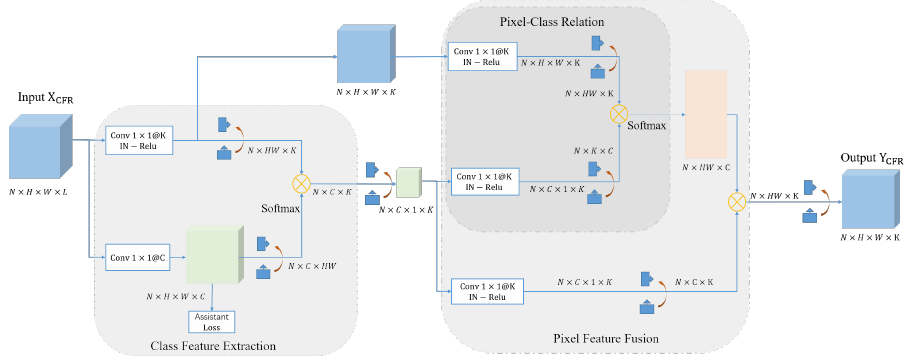
Figure 5. The structure of